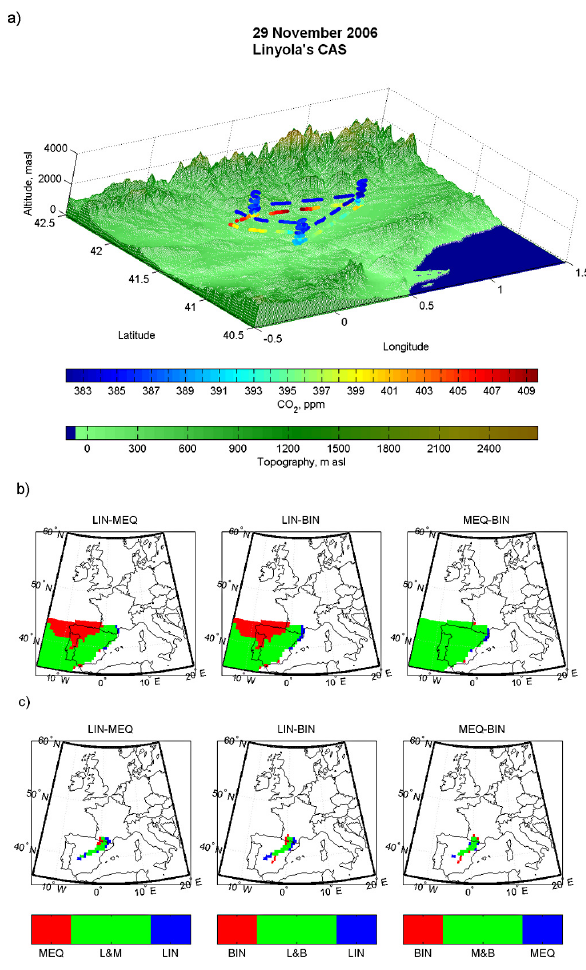
Fig. 5. Same as Fig. 4 but for 29 November 2006. Fig. 6. Same as Fig. 4 but for 24 August